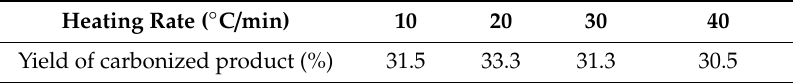
Table 3. The yield of the carbonized product at di ff erent heating rates.